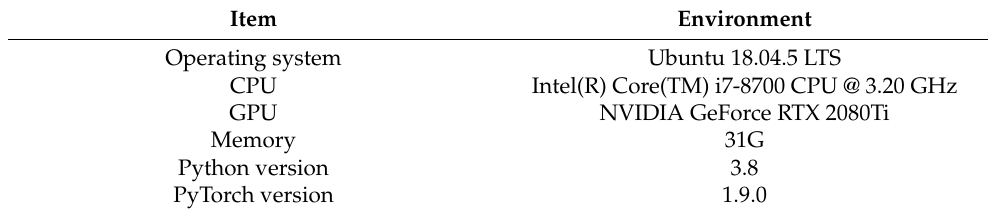
Table 2. The hardware and software